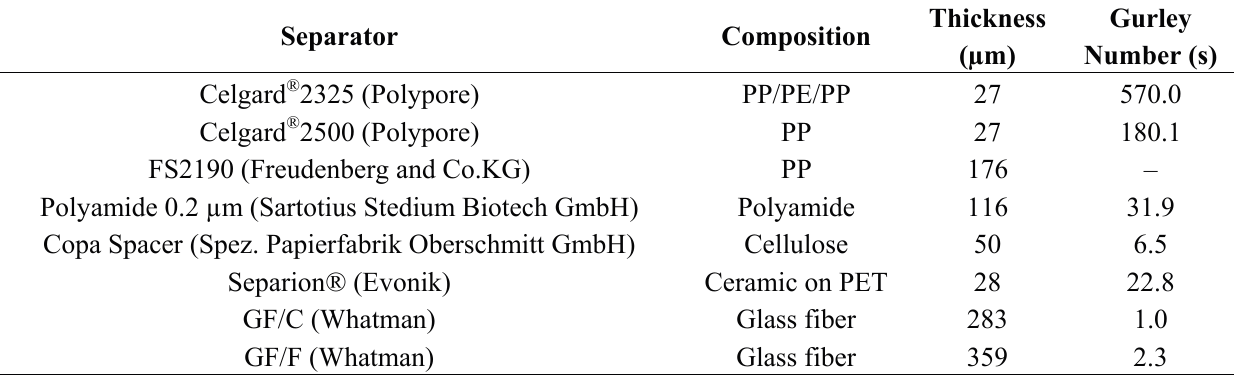
Table 1. Composition, thickness and air permeability (Gurley numbers) of the